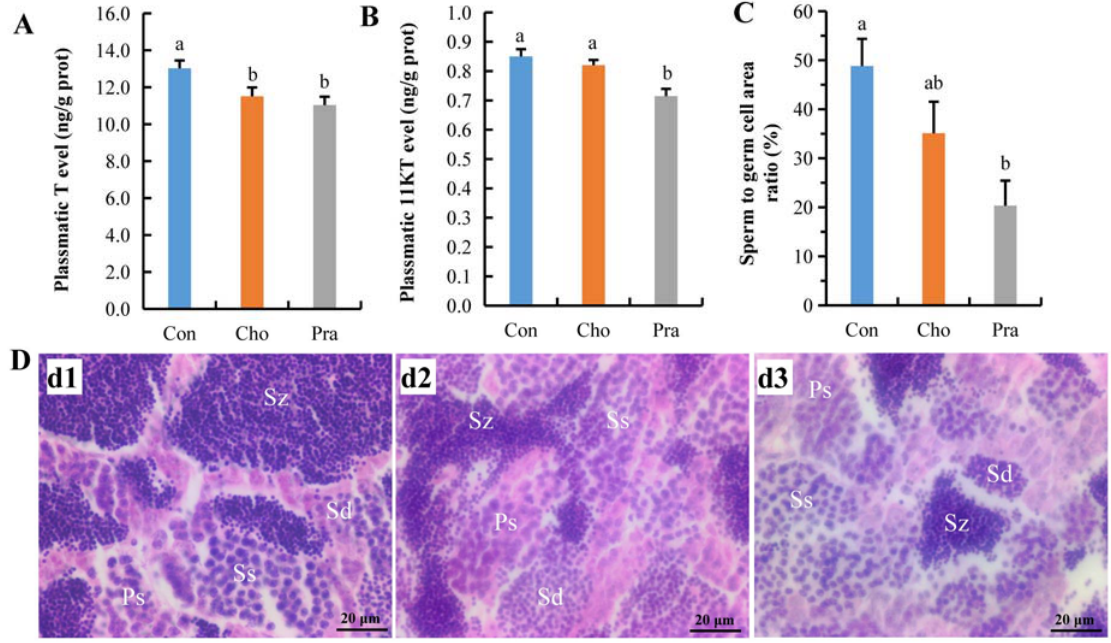
Figure 3. The changes in testis sex hormone levels and the development of testis; ( A ) T; ( B ) 11KT; ( C ) statistical result of sperm to germ cell area ratio; ( D ) paraffin sections of testis; d1: Con, d2: Cho, d3: Pra; Ps: primary spermatocyte; Ss: secondary spermatocyte; Sd: spermatid; Sz: spermatozoa. All statistical data were expressed as mean ± SD. There is a significant difference between the two groups without the same letter at p < 0.05 level.